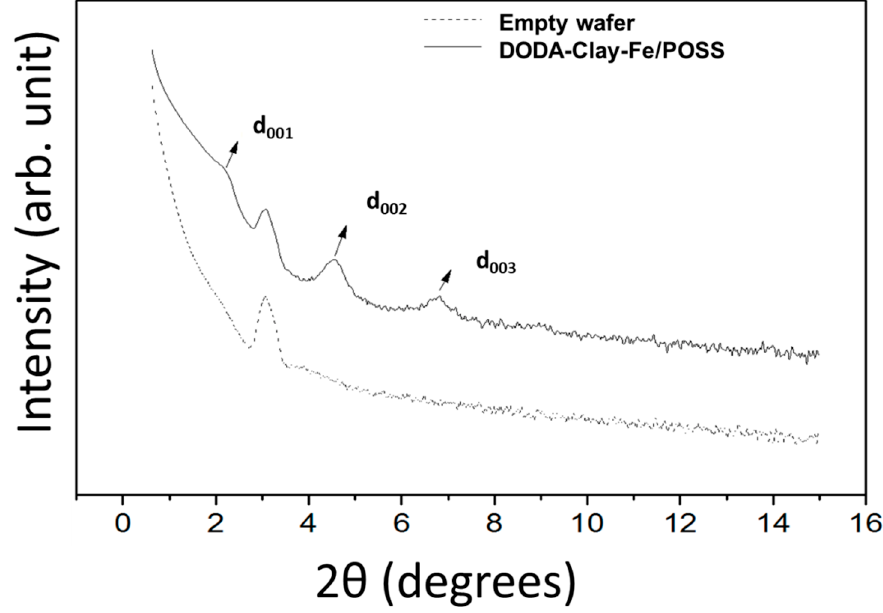
Figure 2. X-ray reflectivity patterns of 34-layer thick DODA-clay-Fe / POSS hybrid film deposited following the preparation route in Scheme 1.